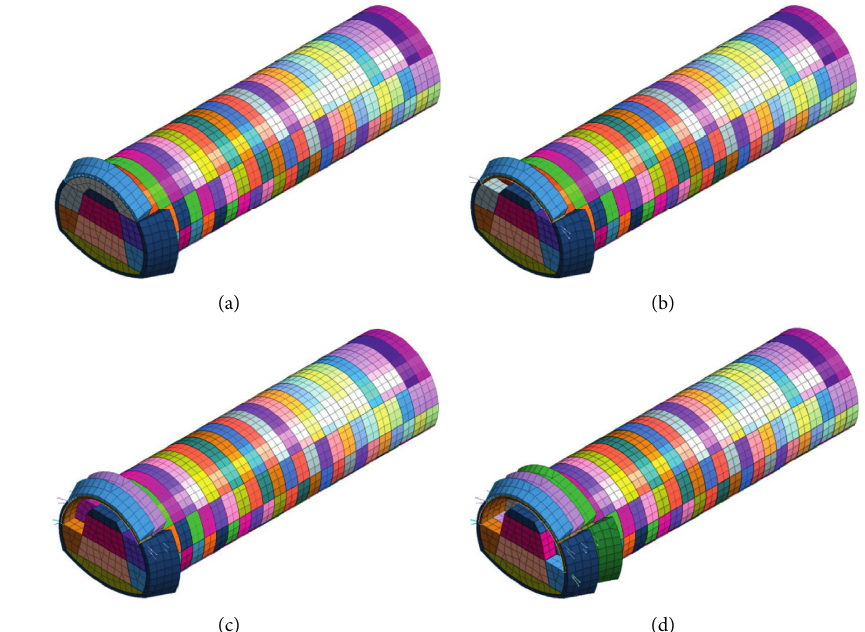
Figure 9: The first four construction consequences of STM: (a) construction of advanced support, (b) Stage 1, (c) Stage 2, and (d) Stage